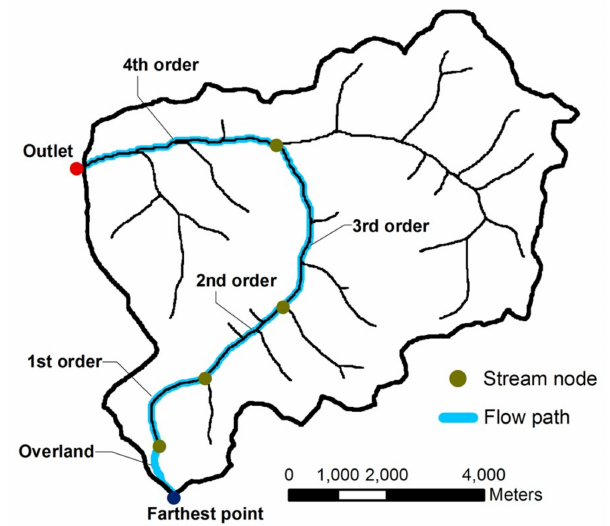
Figure 11. The longest drainage path from the farthest watershed ridge to the outlet.